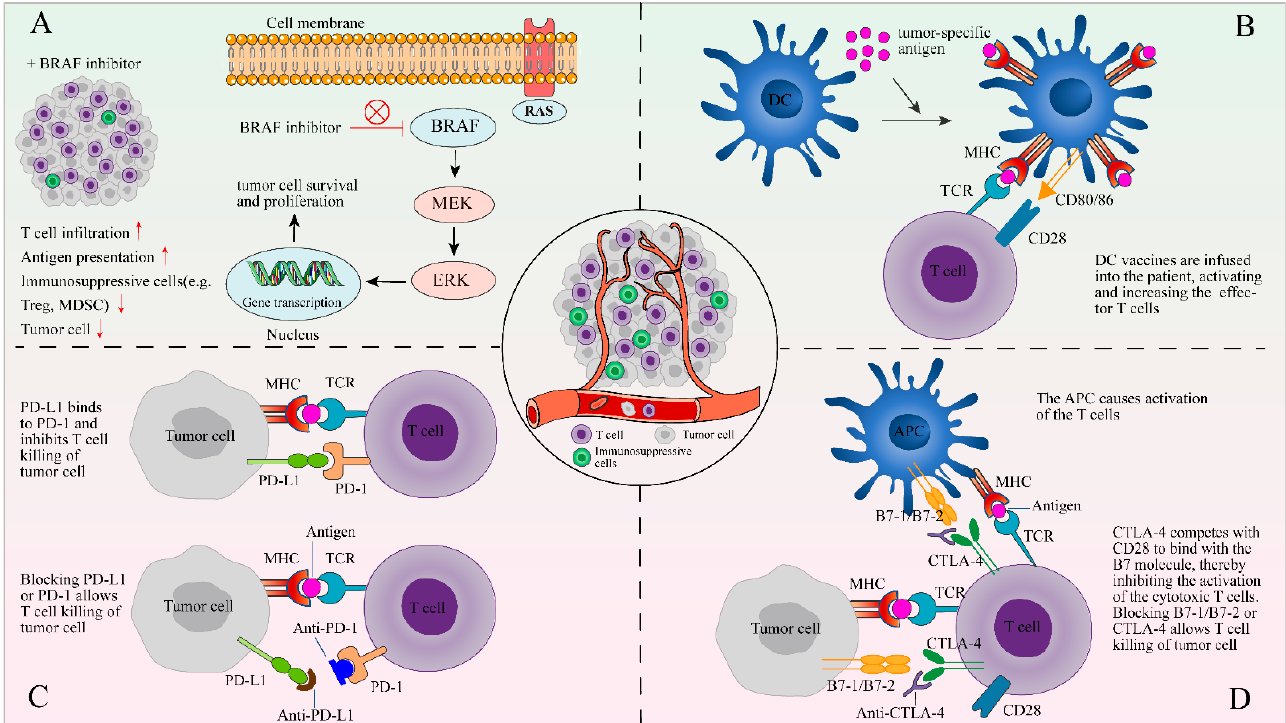
Figure 2. The combination of TIL therapy and other therapies. The following four methods of combined therapy are described in the form of figures: ( A ) a BRAF inhibitor can reduce immunosup- pressive signals and facilitate tumor infiltration of lymphocytes; ( B ) DCs are stimulated by signals and loaded with tumor-specific antigens on MHC to activate the antigen-specific T-cells; ( C ) PD-L1 or PD-1 blockers may prevent the interaction of PD-1 and PDL-1 between TILs and tumor cells; and ( D ) blocking CTLA-4, which competes with CD28 to bind the B7 molecule, allows T cell killing of tumor cell.